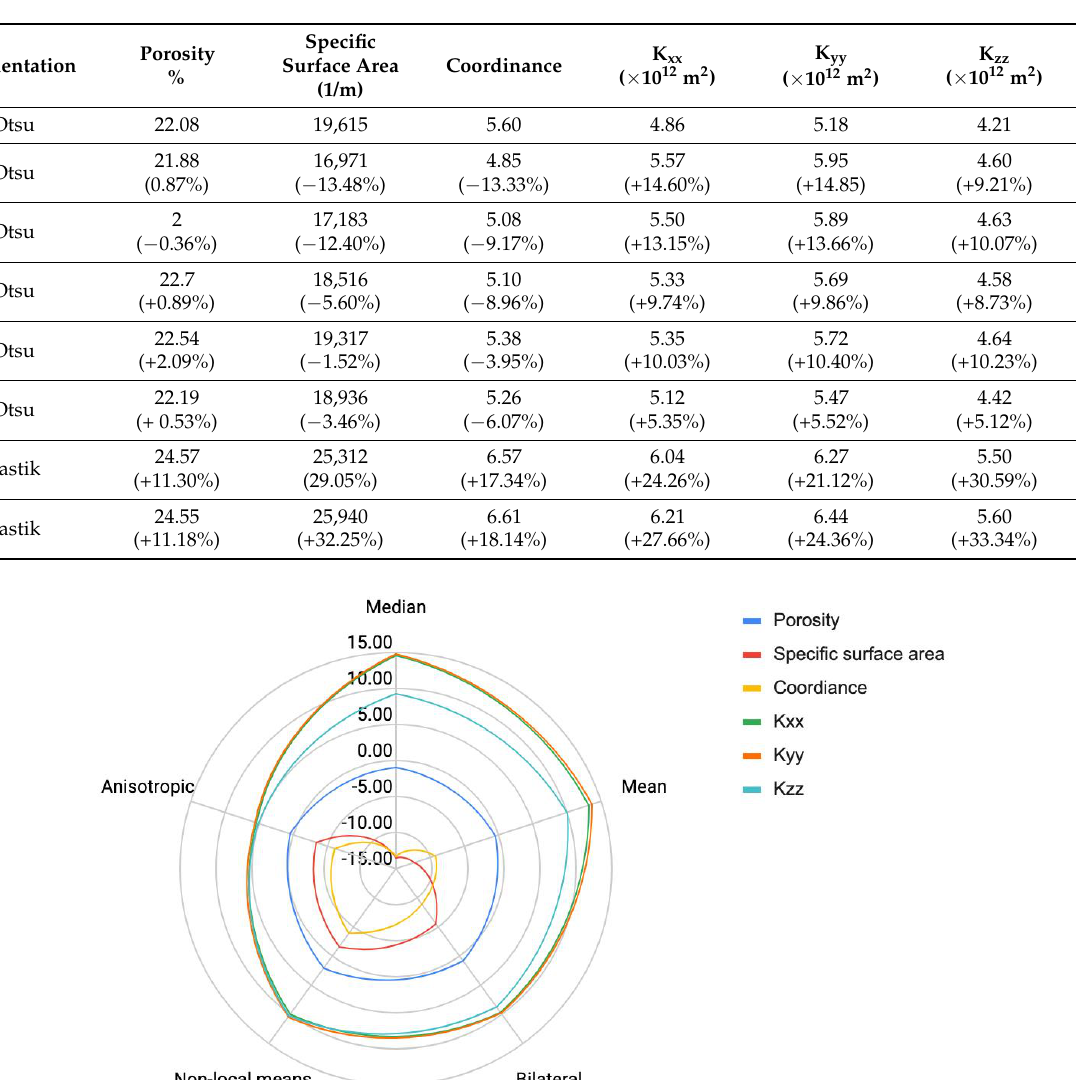
Table 1. Porosity and normalized porosity, specific surface area, coordinance and permeability for the different filter/segmentation-tested couples with the reference, considered as Otsu thresholding of the raw image expressed in voxels and %.